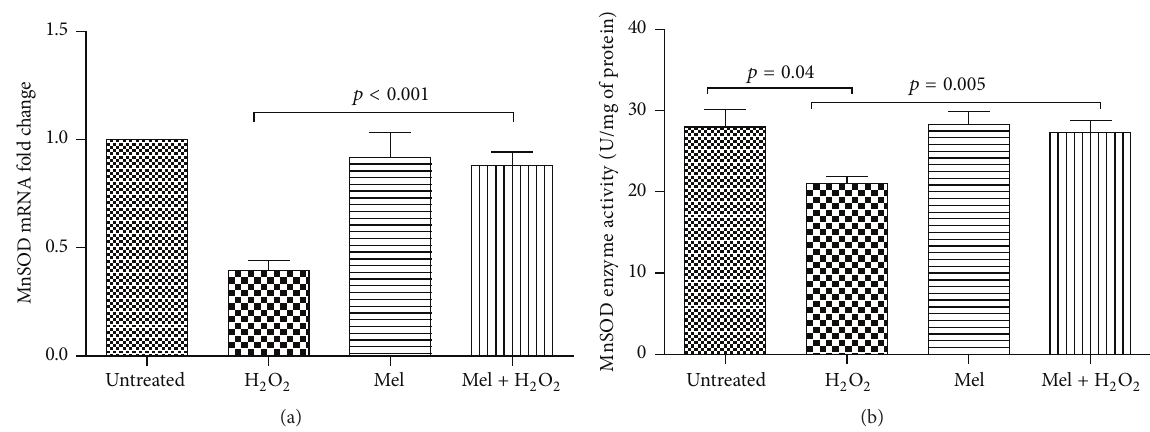
Figure 3: Effect of melatonin, H healthy subjects. PBMCs were treated as follows: untreated (only with 0.1% DMSO for 12h); melatonin (1mM) for 12h; H 2 h; and melatonin plus H were treated with 0.1% of DMSO as a control. Data are expressed as mean ± SEM.